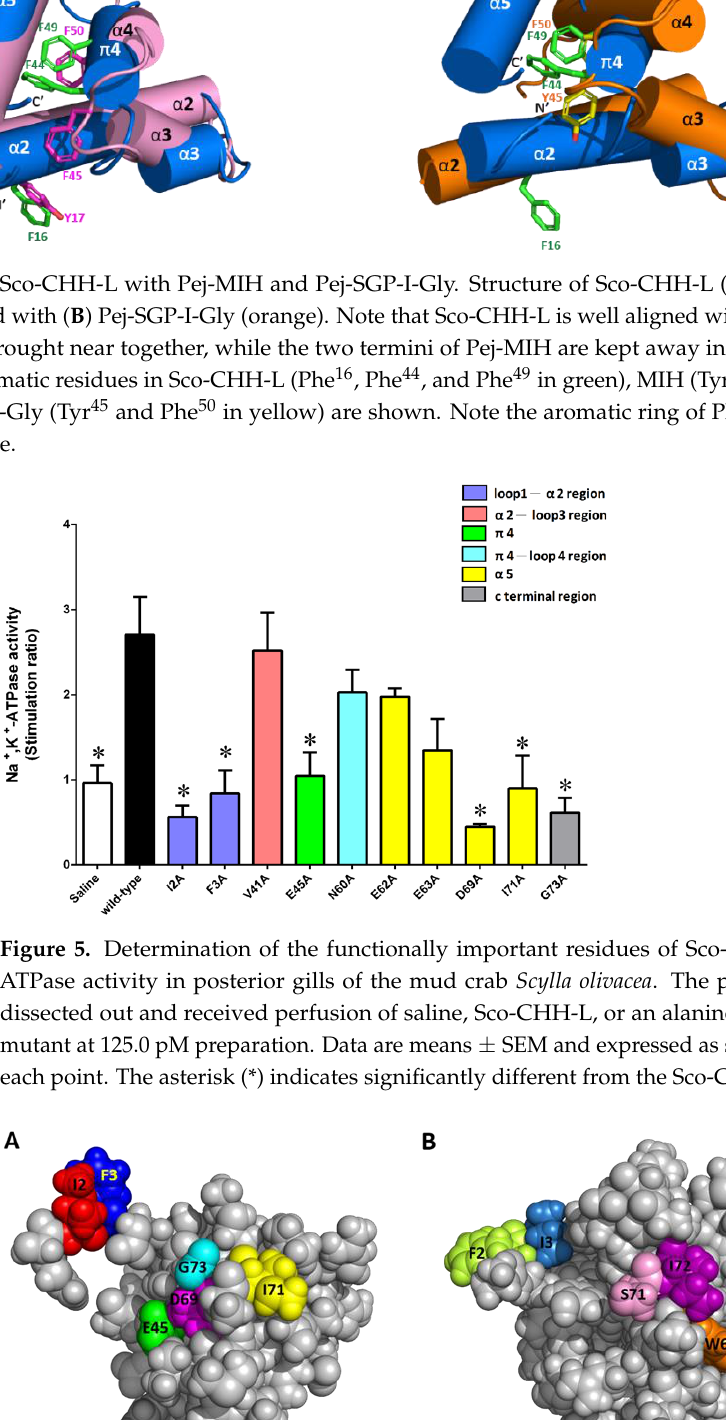
Figure 3. Sequence alignment and secondary structure of four CHH/ITP peptides. Sequence alignment and secondary structure of four CHH-superfamily peptides. Amino acid sequences of the mature peptide of three Type-I peptides, Sco- CHH, Sco-CHH-L, and Pej-SGP-I-Gly, and that of a Type-II peptide, Pej-MIH, are aligned. Accession number for the amino acid sequence is, respectively AY372181, EF530127, AB007507, and P55847. For Sco-CHH-L, Pej-SGP-I-Gly, and Pej-MIH, location of the secondary structures is given. The conserved pattern of disulfide bridge connectivity (Cys 7 –Cys 43/44 , Cys 23/24 – Cys 39/40 , and Cys 26/27 –Cys 52/53 ) is indicated by orange lines.